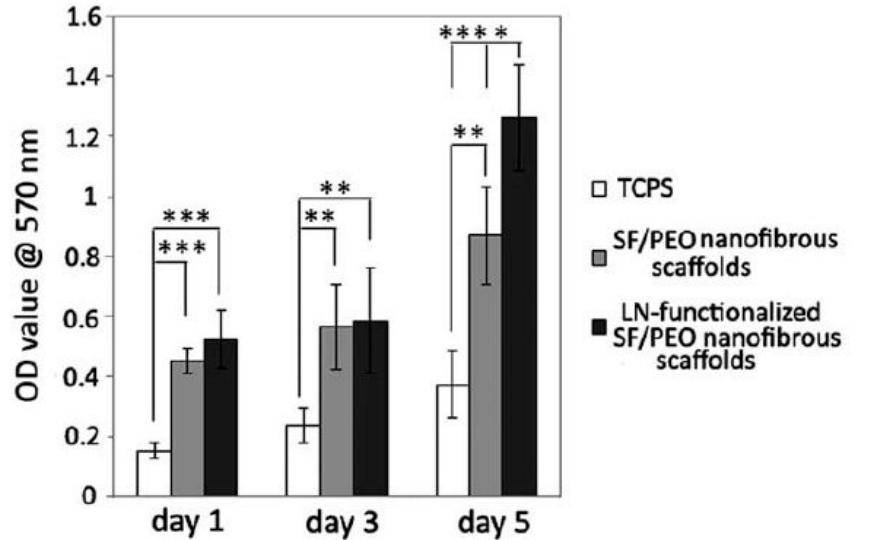
Figure 21. Proliferation of Schwann cells seeded on TCPS, electrospun silk fibroin (SF)/ polyethylene oxide (PEO) nanofibrous scaffolds and electrospun laminin (LN)-functionalized SF/PEO nanofibrous scaffolds at day 1, 3 and 5 ( p < 0.01 (**), p < 0.005 (***) and p < 0.0001 (****)—reproduced with